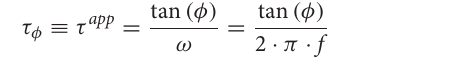
1,024 points and 6.8 µ s dwell-time per ×